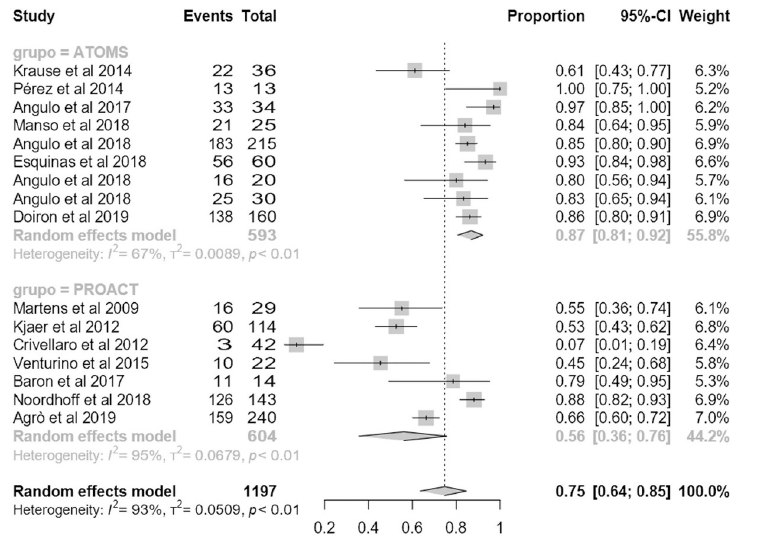
Fig 4. Forest plot of studies analyzed for satisfaction